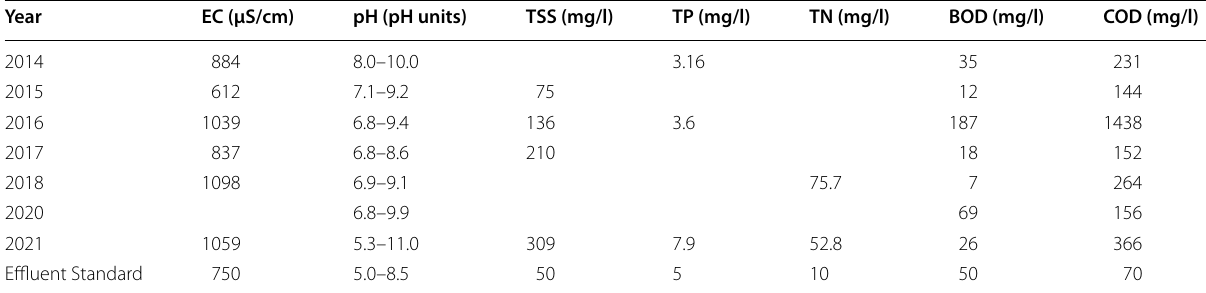
Table 1 Domestic effluents against wastewater discharge standards